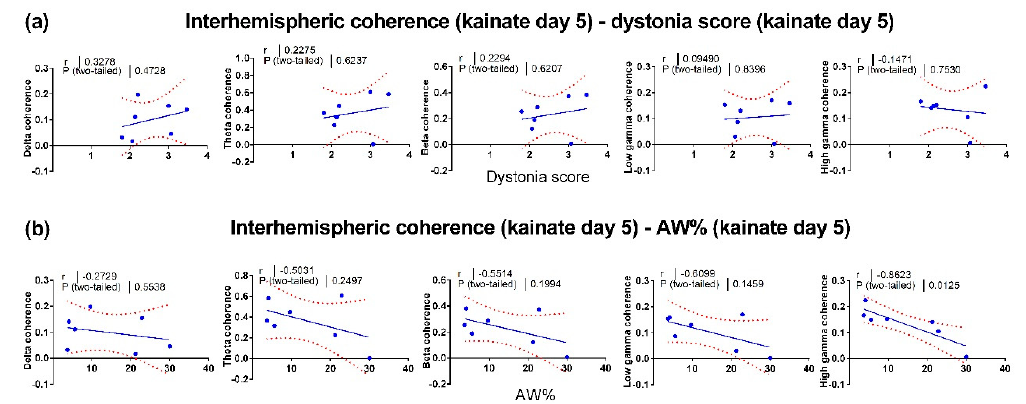
Figure 4. Pearson correlations between left and right motor cortices interhemispheric coherence and behavior in baseline and the first day of cerebellar kainate application. ( a ) Linear regression of active wake percentage in baseline day versus interhemispheric coherence (delta, theta, beta, low gamma, high gamma bands). ( b ) Linear regression of dystonia score versus interhemispheric coherence (delta, theta, beta, low gamma, high gamma bands) in kainate day 1. ( c ) Linear regression of active wake percentage versus interhemispheric coherence (delta, theta, beta, low gamma, high gamma bands) in kainate day 1. Each point corresponds to one subject. The plain and dotted curves denote the 95% tolerance and confidence intervals of the linear regression, correspondingly. R and p values are indicated above on each graph.